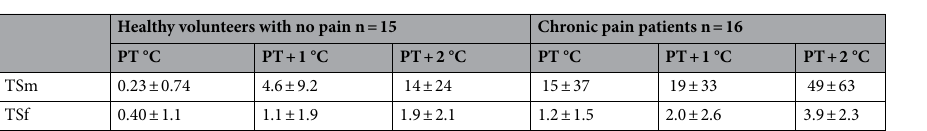
Table 3. Outcome data of TSSP parameters in Healthy volunteers with no pain and Chronic pain patients. Mean ± S.D. TSm: PI max − PI 1 (VAS × second). TSf: Numbers of times P n + 1 > PI n (times).